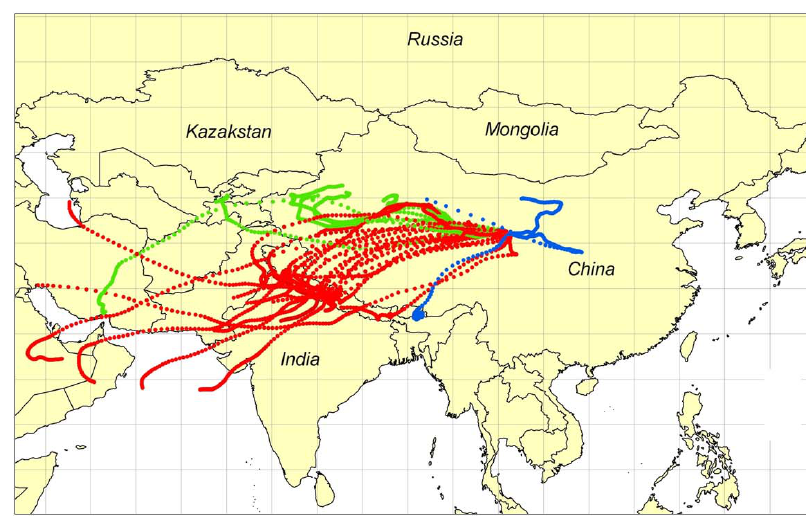
Fig. 9. Daily backward trajectories ended at WLG at a height of 1000m above ground in January 2008.